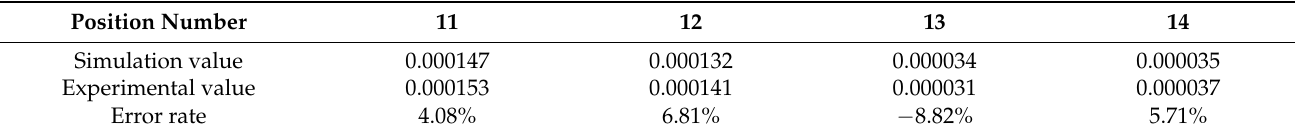
Table 3. Comparison between the simulation strain values and the experimental strain values of the COF